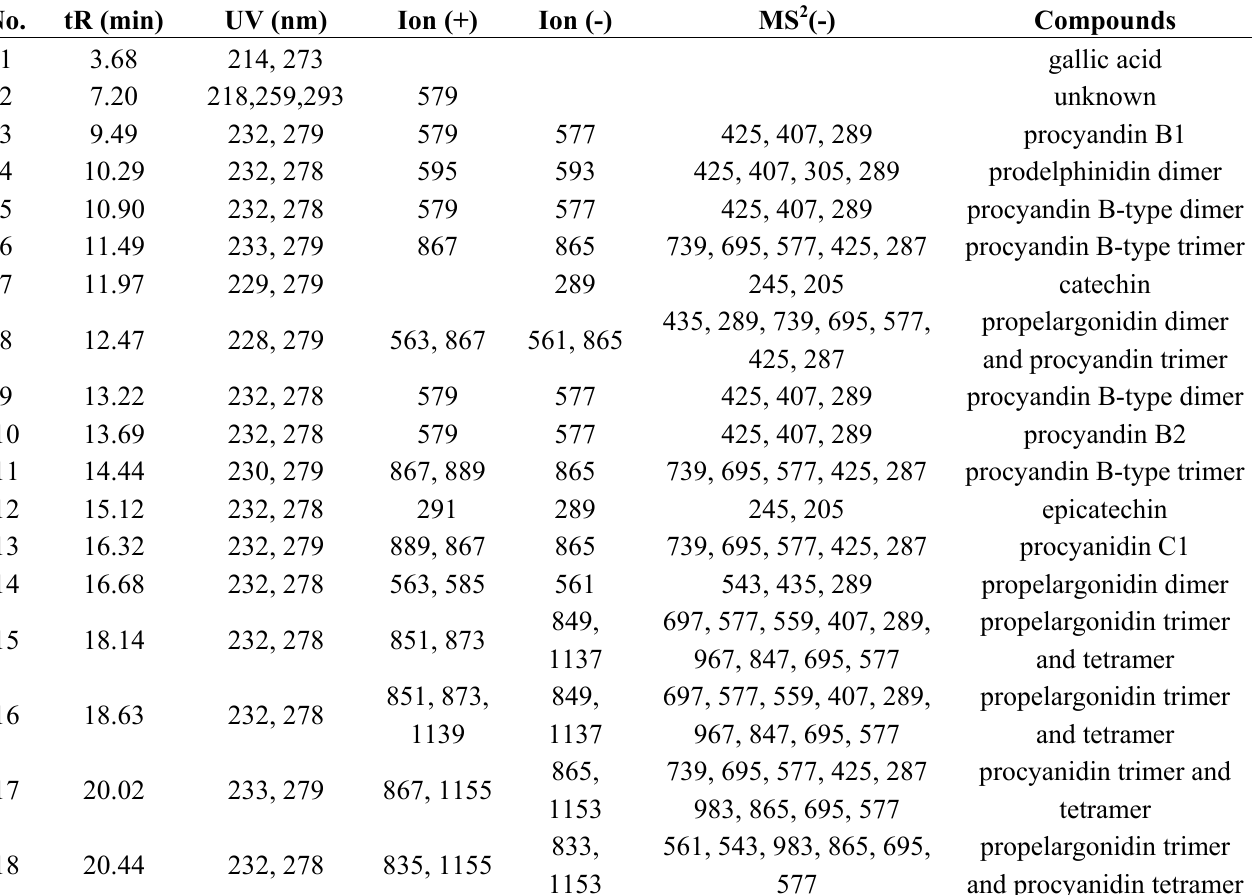
Figure 1. HPLC-DAD-ESI-MS profile of the ethyl acetate fraction of S. suberectus MS: (+) ESI; PDA: (280